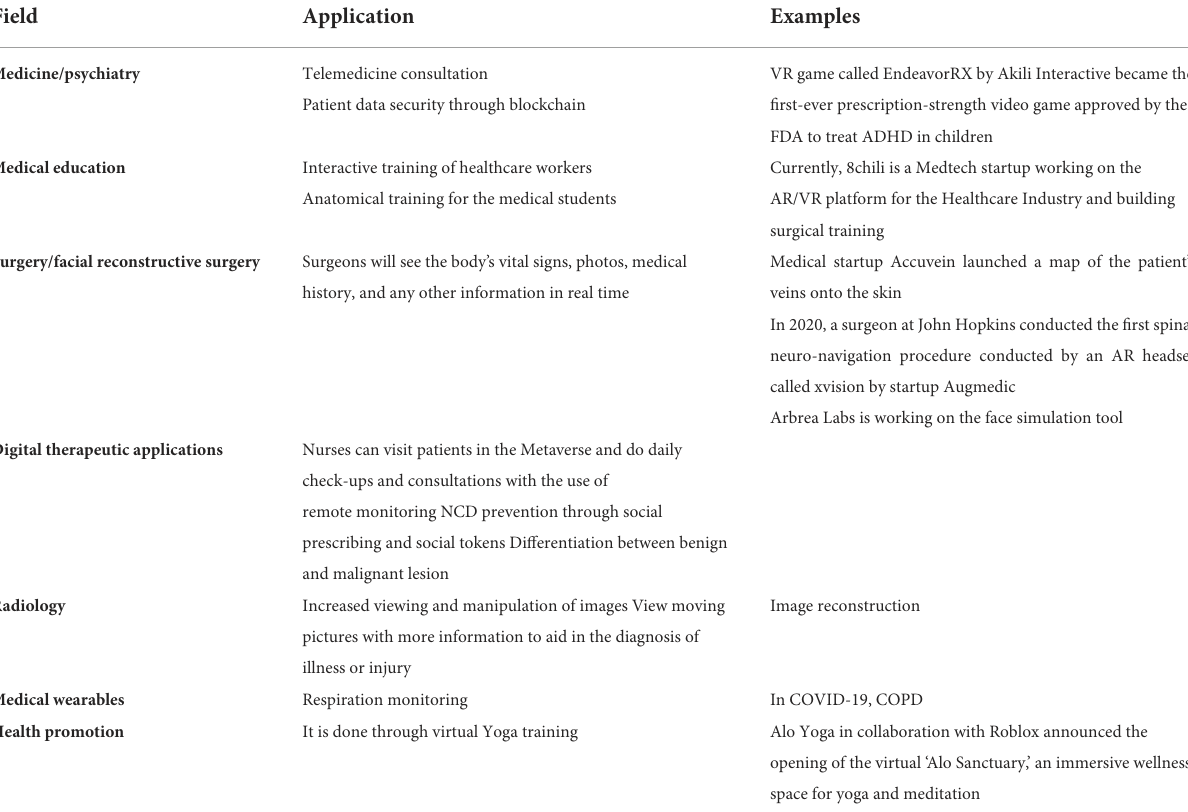
TABLE 1 Uses of